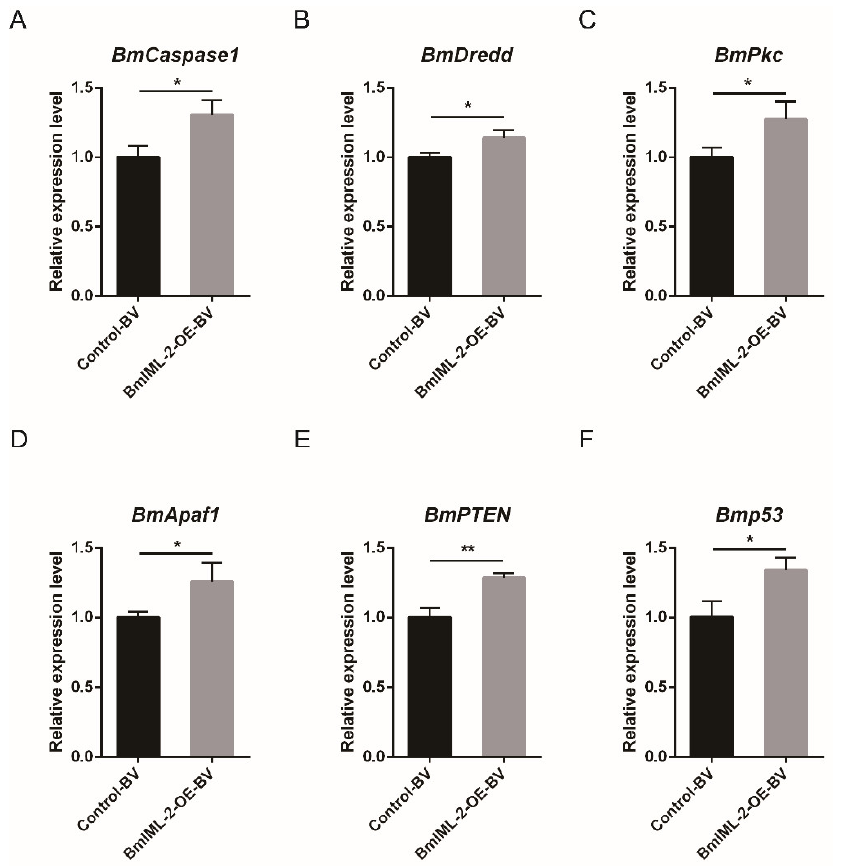
Figure 6. Transcription level changes of selected apoptosis-related genes in virally infected BmIML-2 overexpressed cells ( A – F ). The mRNA levels of genes were detected by using qRT-PCR assay after transfection of BmIML-2 overexpression vector. The data were calibrated by using BmGAPDH . Error bars represent means ± S.D. of three separate experiments. Asterisks indicate significant differences compared with the control (unpaired t -test; *, p < 0.05; **, p < 0.01; ns, not significant).